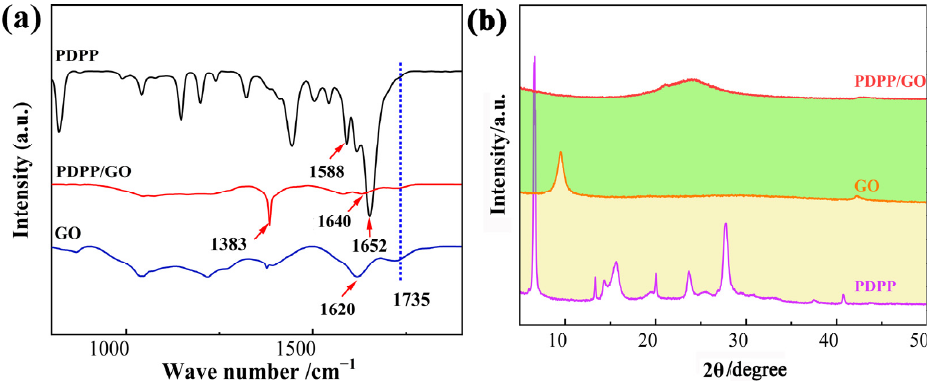
Figure 1. SEM images of PDPP ( a , b ), GO ( c ), and PDPP/GO ( d - g ). The element mapping images of PDPP/GO with C ( h ), N ( i ), and O ( j ) elements.